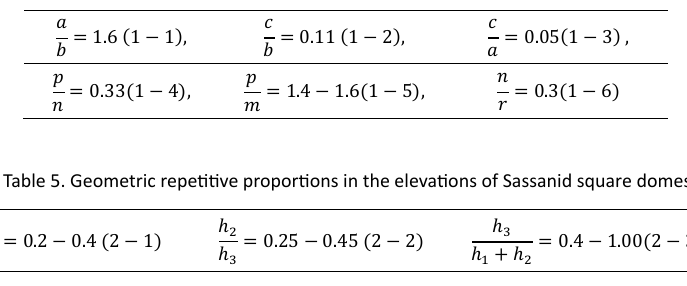
Table 4: Geometric repetitive proportions in the plans of Sassanid square domes Table 4. Geometric repetitive proportions in the plans of Sassanid square domes